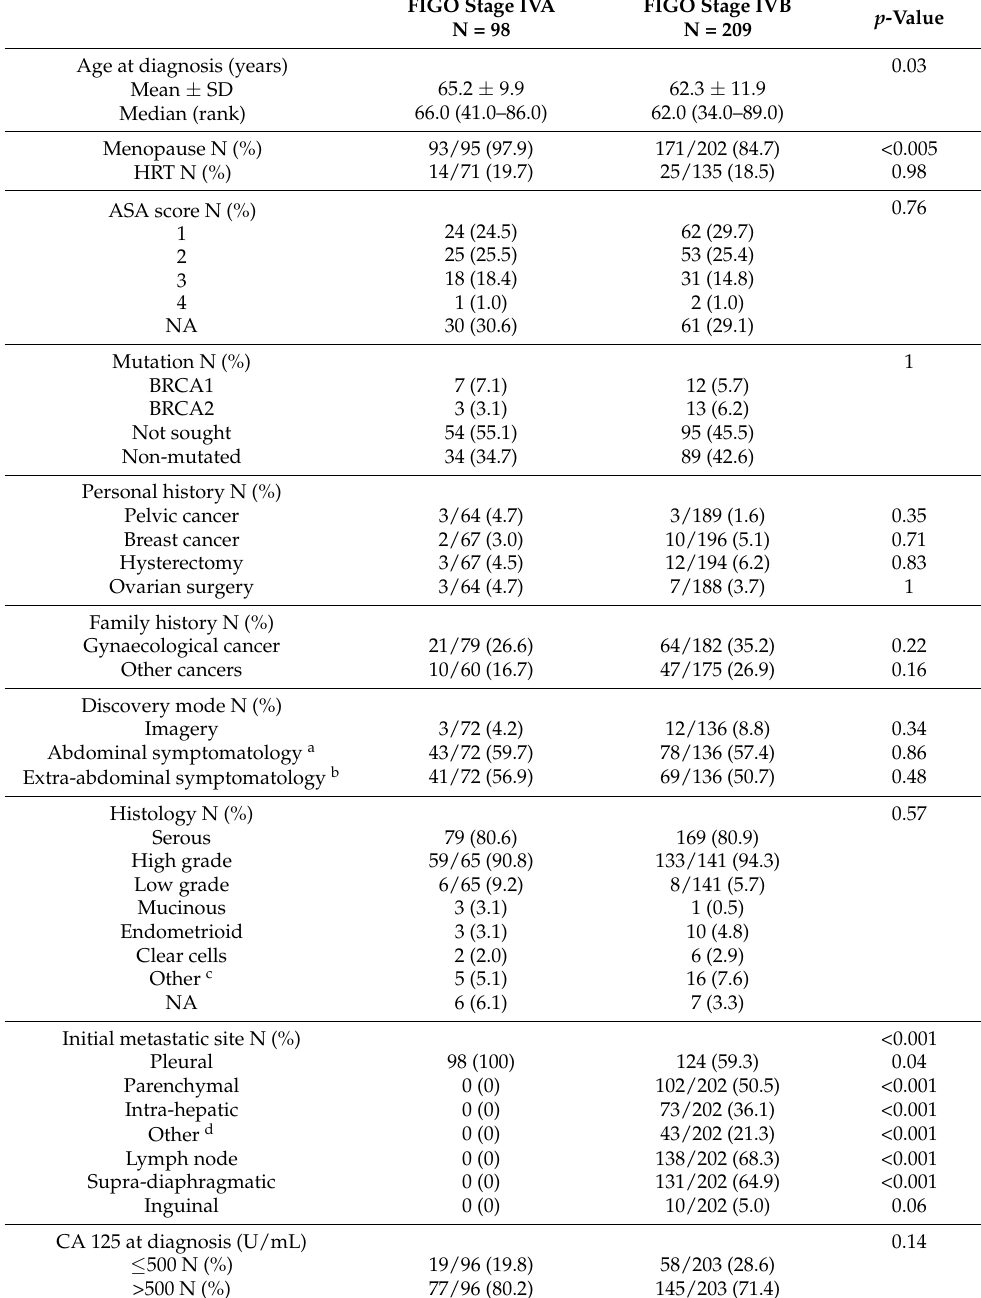
Table 1. Characteristics of patients and their tumors according to FIGO stage. SD: standard deviation, HRT: hormone replacement therapy, ASA score: American Society of Anesthesiologists score, ASA